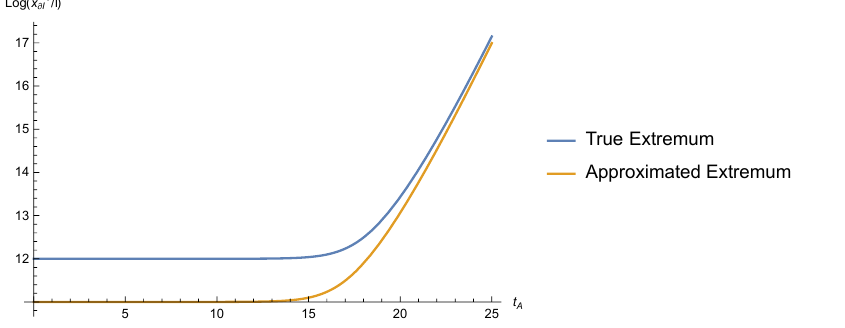
Figure 10 . Comparison of the approximate island and the “true” island found by solving ∂ − S ( R ) at x − = 0 . To produce the figures we took ‘ = 1 , Φ s = 50 , Φ 0 = 100 , c = 10 , ˆ r/‘ = 10 3 . ∂I on x − = 0 for x + we find the “true” extremum and compare this with the approximate is- ∂I land. It turns out that again after a time t ’ 2Φ confirming the validity of our